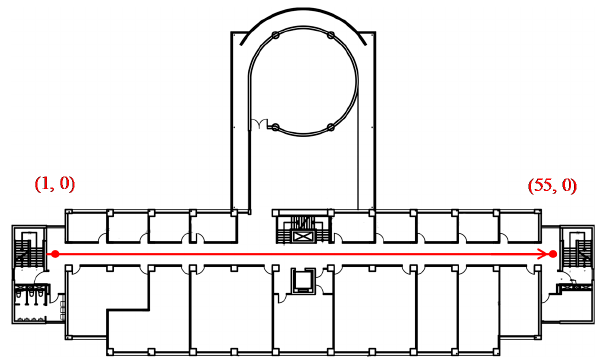
Figure 9. Floor plan of the experimental site. Sensors 2018 , 18 , 3